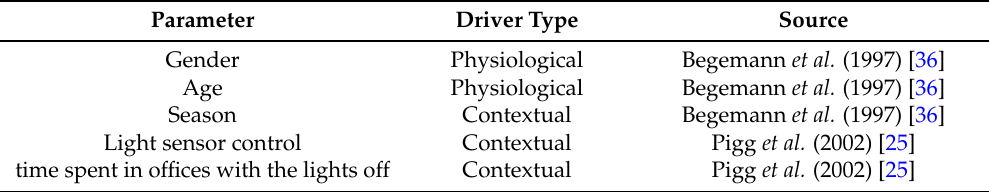
Table 3. List of variables that have been found not to drive lighting behaviour.